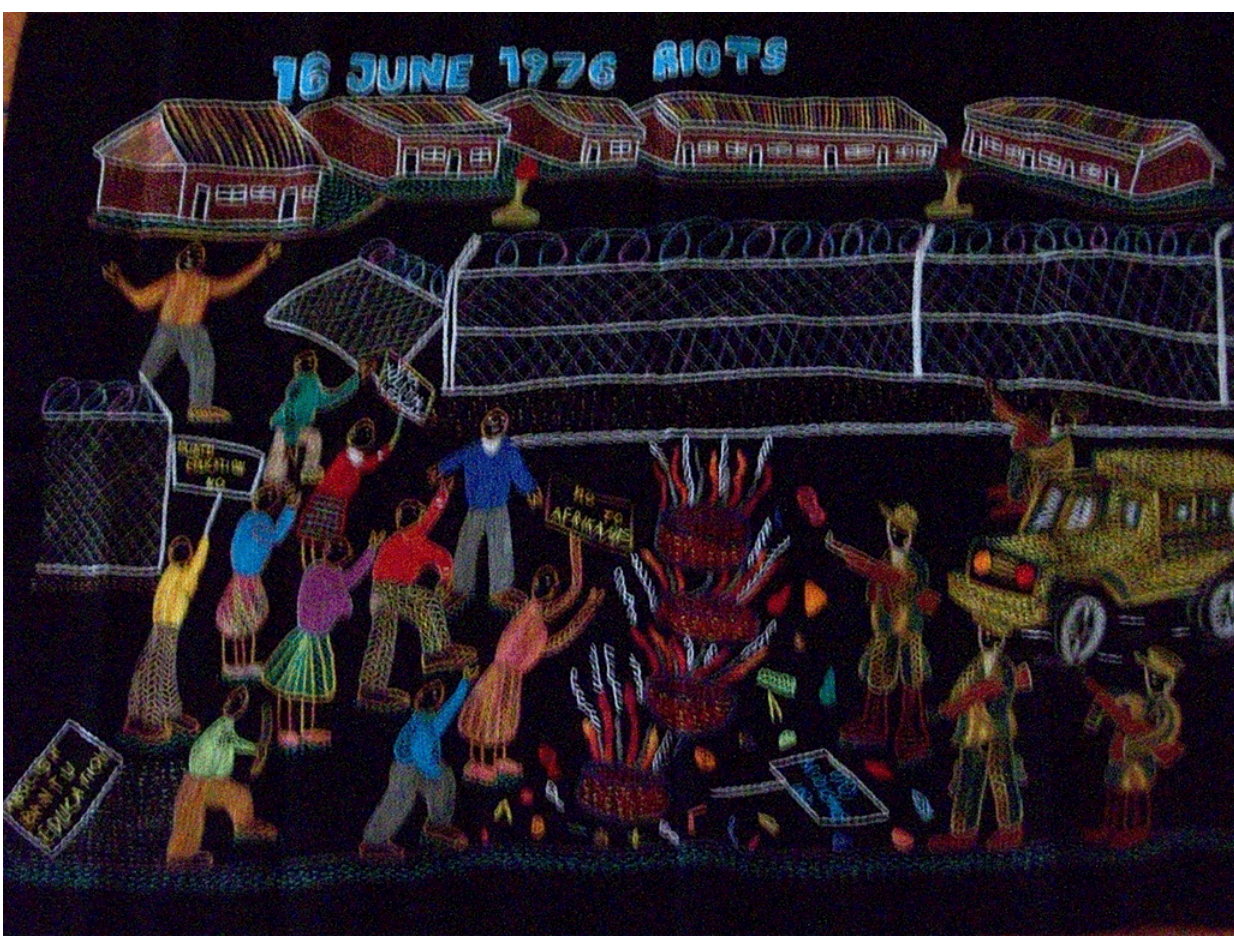
Figure 1. Keneilwe’s